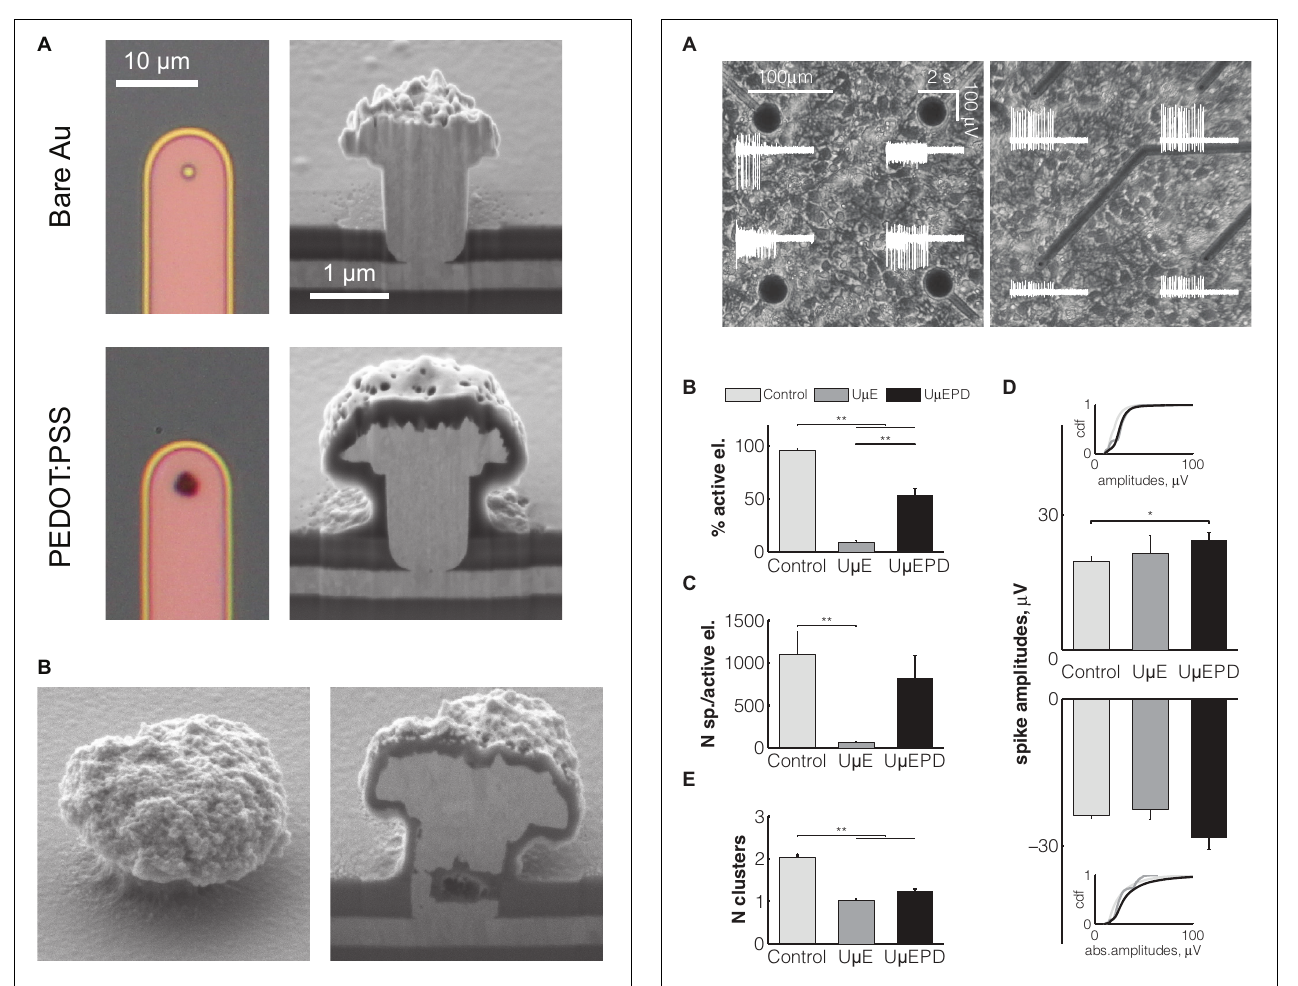
FIGURE 4 | Elementary properties of different types of electrodes: conventional planar (light gray, n = 12 MEAs), gold ultramicroelectrodes (U µ E, dark gray, n = 6 MEAs), PEDOT:PSS ultramicroelectrodes (U µ EPD, black, n = 10 MEAs). Representative phase-contrast micrographs show cortical cells at the second week after plating on the glass surface with conventional planar electrodes ( A , left) and with PEDOT:PSS ultramicroelectrodes ( A , right). The white traces represent the electrical activity detected by the corresponding electrodes within an interval of 4 s. The percentage of active electrodes is represented as percentage of those electrodes detecting signals (B) . The average number of spikes per active electrode is displayed in (C) , together with the average value of detected amplitudes with positive (top) and negative (bottom) deflections (D) . The average number of different spike waveforms (clusters) detected by single electrode is displayed in panel (E) . Data are shown as the mean ± SEM and statistical significance between groups was assessed using a two-way ANOVA and post-hoc Fisher’s